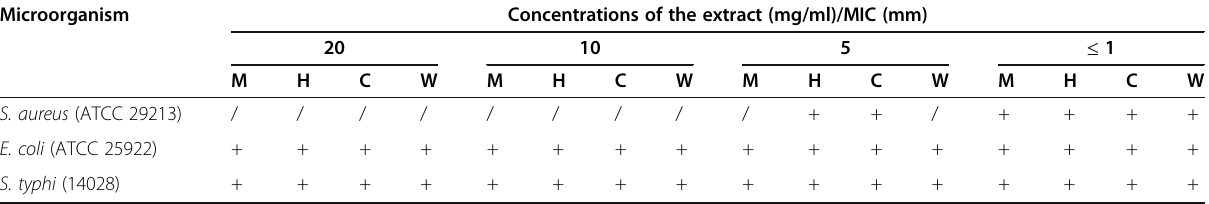
Table 2 Minimum inhibitory concentration (MIC) of T. dodoneifolius on the test bacteria Microorganism Concentrations of the extract (mg/ml)/MIC (mm)